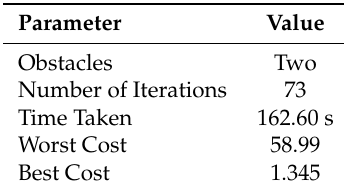
Table 5. Flight D Real Time Trajectory Planner